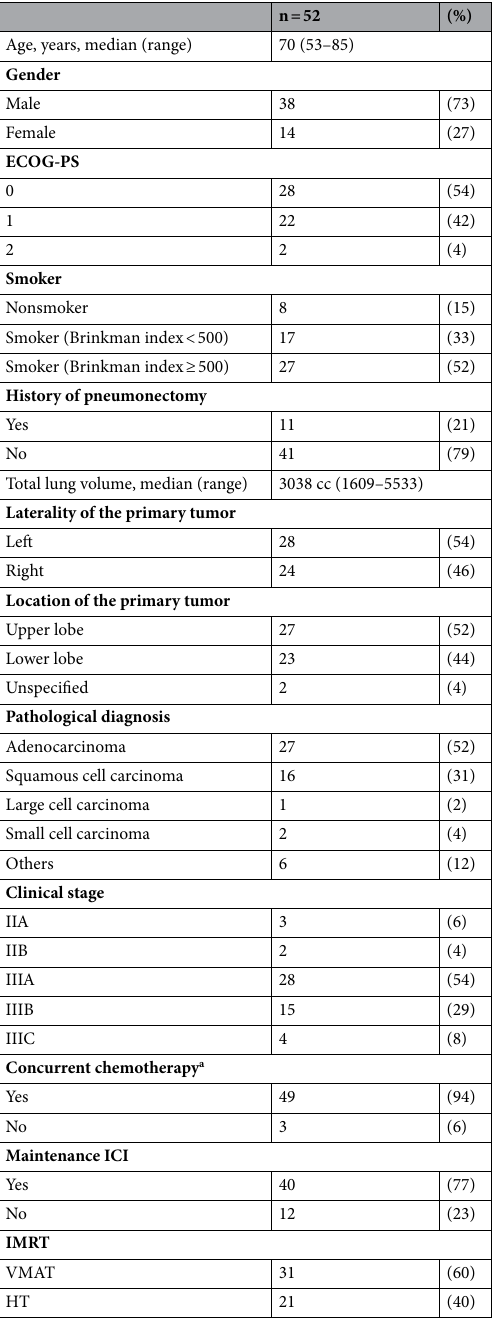
Table 1. Patient characteristics. ECOG-PS Eastern Cooperative Oncology Group performance status, ICI immune checkpoint inhibitor, IMRT intensity-modulated arc therapy, VMAT volumetric modulated arc therapy, HT helical tomotherapy. a Five patients concurrently receiving immune checkpoint inhibitors were